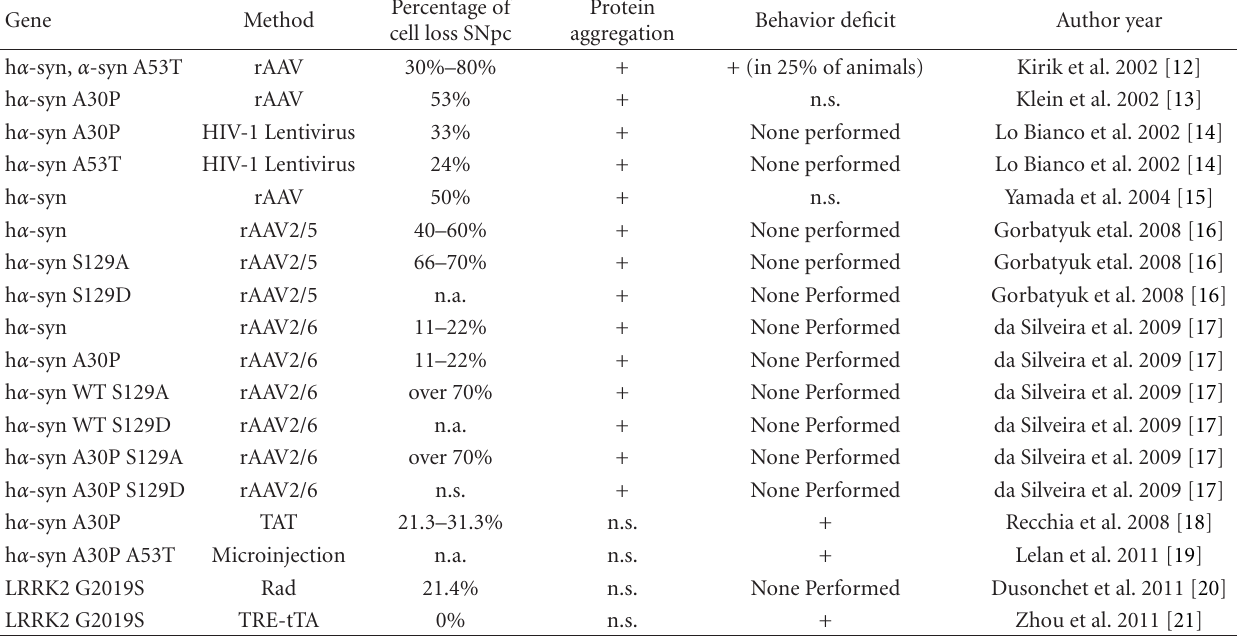
Table 1: Summary of studies using genetic rat models of PD. Note that % cell loss SNpc is percentage of cell loss in the substantia nigra, pars compacta, relative to number of cells in the intact, untreated controls; “n.a.” indicates data for percentage loss of SNpc cells was not available; plus sign (+) indicates significant di ff erences and “n.s.” indicates non-significant di ff erences between genetically altered rats and wild-type controls on measures of protein aggregation or behavioral deficits (i.e., stimulant-induced rotational activity, paw placement in cylinder task, and/or spontaneous motor activity in